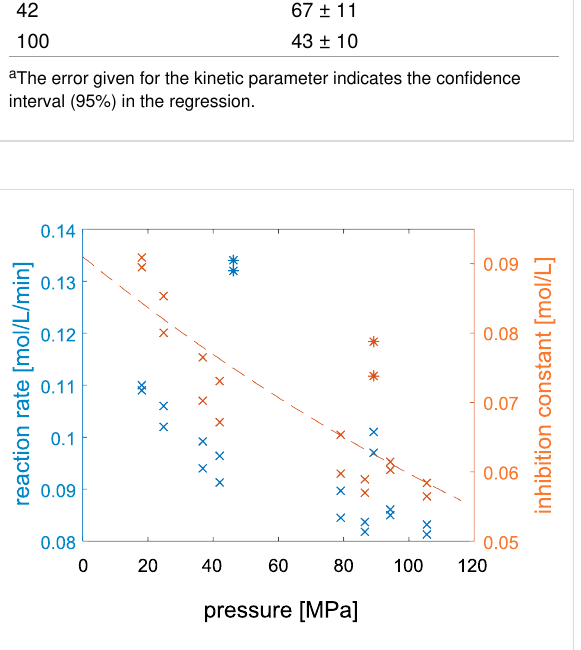
Figure 10: Measured reaction rate (left) and the determined inhibition constant by pyruvate (right) at different pressures. Conditions: 450 mM GlcNAc, 400 mM pyruvate, 2 mL/min, 40 °C, 0.21 mL reactor volume, 57 mg particles loaded with epimerase. Points determined as outliers are marked using